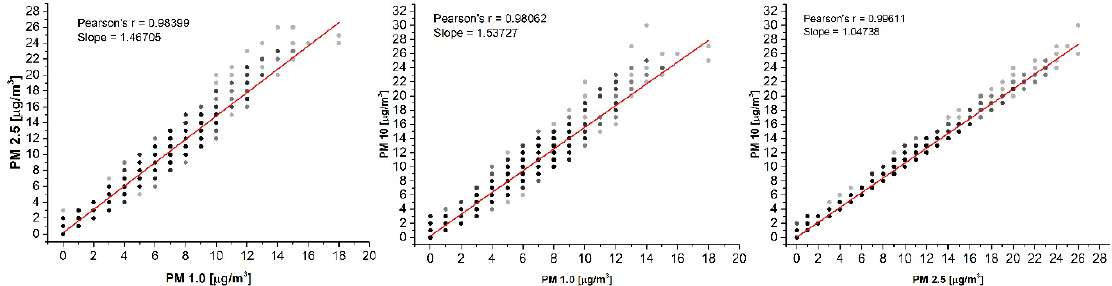
Figure 8. Correlation among the PM readings of the PMS5003 monitor. The data represent all measurements for one representative day. Similar results were obtained for the remaining single days, as well for the whole set of data.